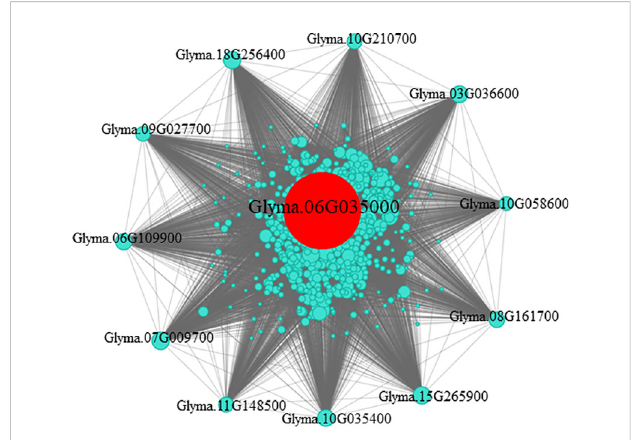
FIGURE 5 Co-expression network analysis of the hub gene in the turquoise module. The network of highly connected genes in the turquoise module. Red represents the hub gene.